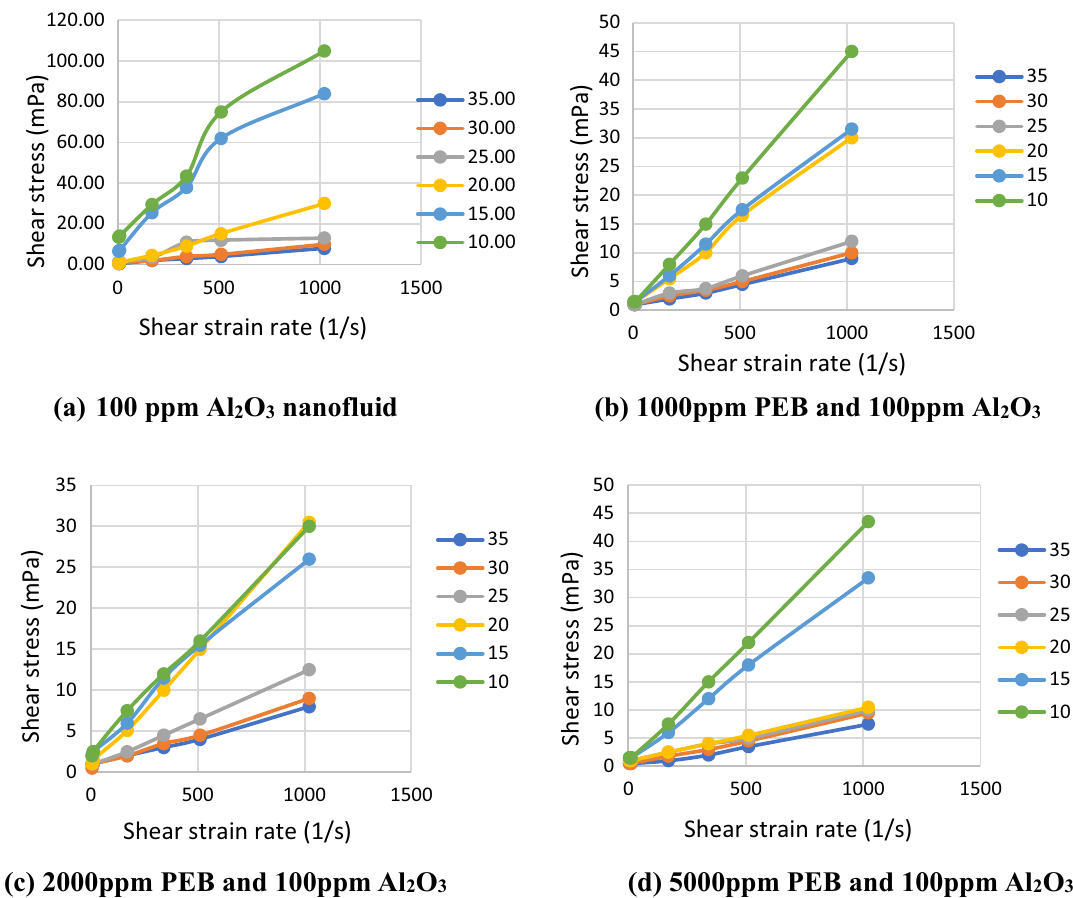
Fig. 3 a 100 ppm Al